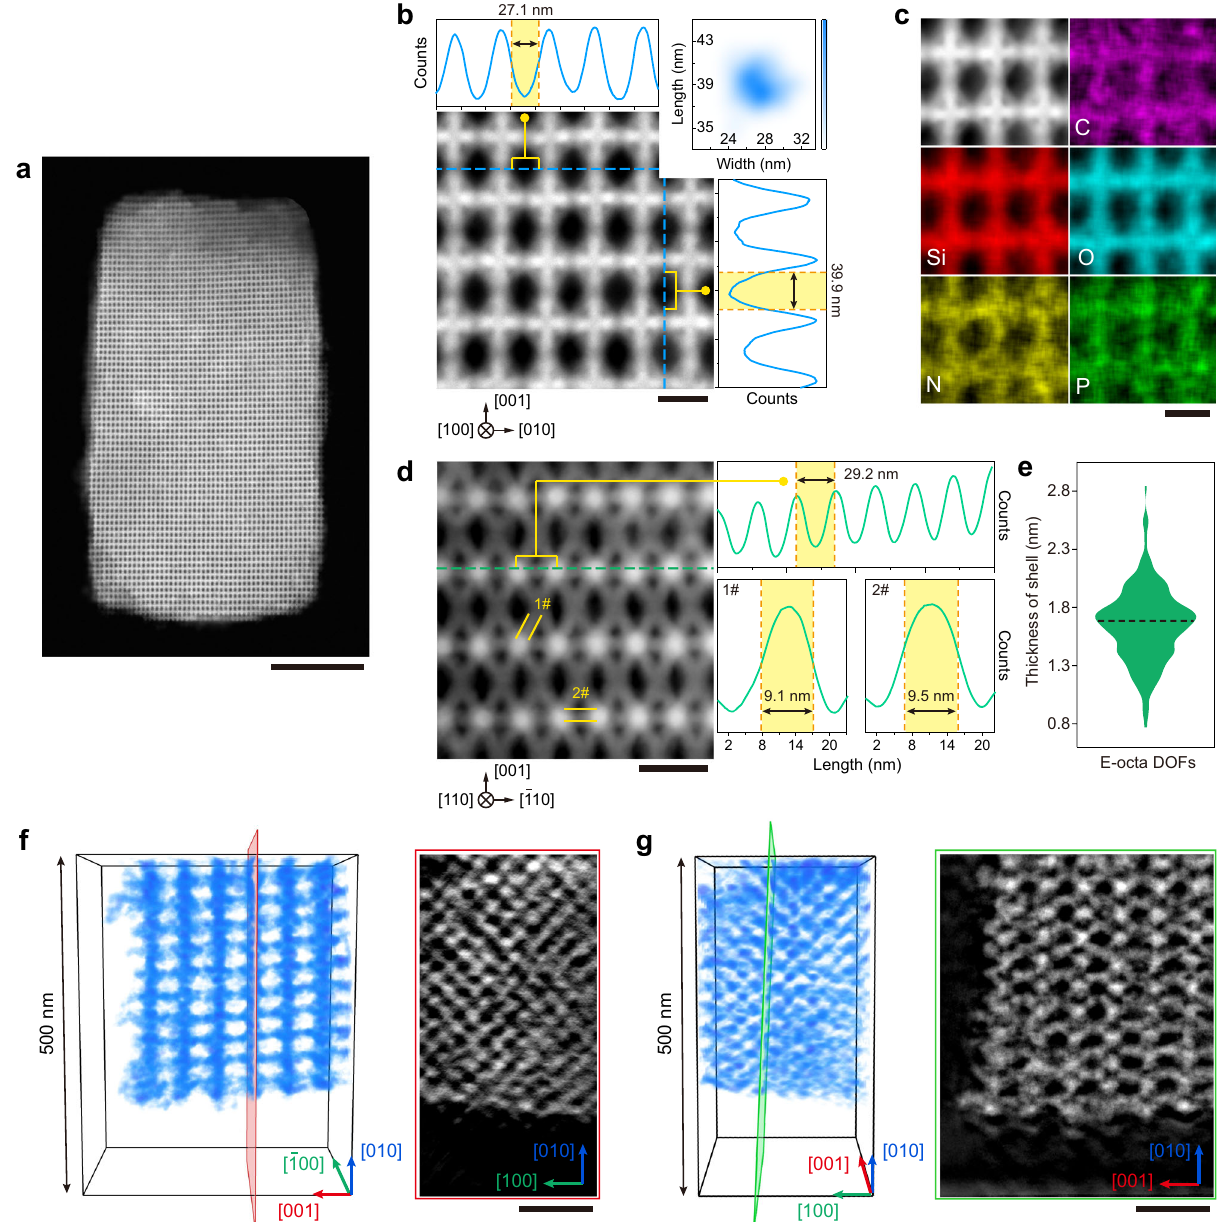
Fig. 4 Structural analysis and reconstruction of cuboid microcrystals. a Representative HAADF-STEM image of an individual cuboid microcrystal. Scale bar: 1 μ m. b Zoomed-in view of a nanoscopic region arbitrarily selected from the crystal oriented along the [100] zone-axis. Top and right panels: size measurements of pores by line pro fi le analysis. Top right panel: size distribution of mesopores. Scale bar: 50 nm. c HR-EDS mapping of the mesoporous con fi guration. C, Si, O, N, and P are coloured in purple, red, cyan, yellow and green, respectively. Scale bar: 50 nm. d Left: zoomed-in image of nanoscopic partial region observed along the [110] zone-axis. Right: length (top panel) and width (bottom panels) measurements of silici fi ed bundles by line pro fi le analysis. Scale bar: 50 nm. e Thickness distribution of the silica shell encapsulated on cuboid crystals. f , g 3D reconstruction of a piece of a microcrystal. The 3D rendered results are exhibited along two perpendicular axes and the cross-sectional images were extracted from the red ( f ) and green ( g ) planes along different directions. Obtained tomographic images are enclosed by corresponding coloured rectangles. Scale bars: 250